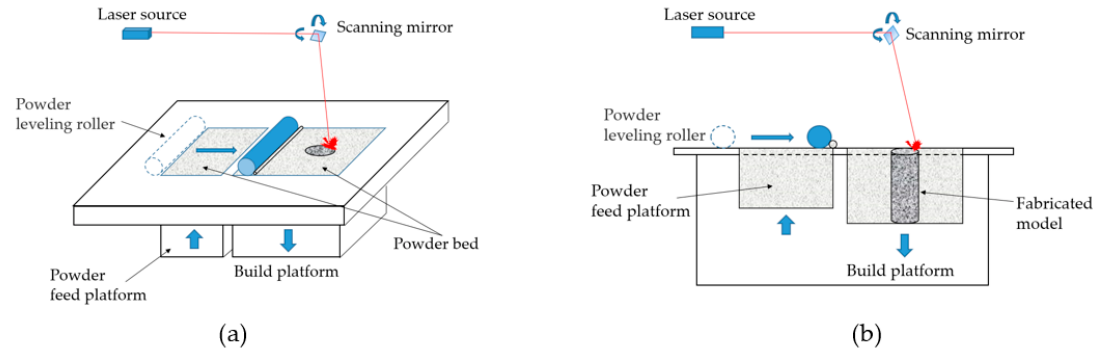
Figure 1. Schematic diagram of the PBF process; ( a ) a schematic model and ( b ) a schematic side view of PBF process.